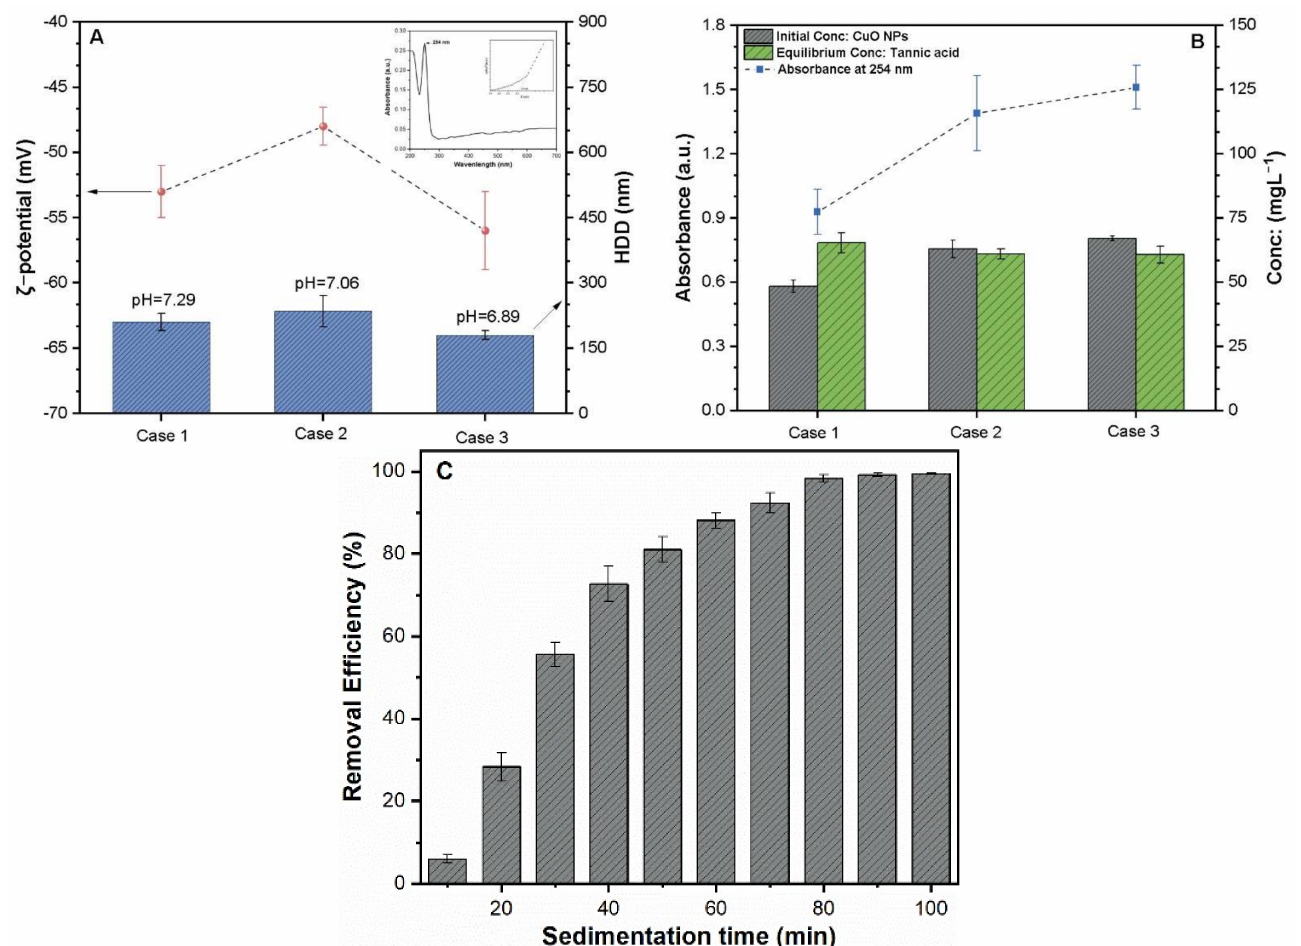
Figure 1. Characteristics of the TA-stabilized CuO NPs suspension. ( A ) ζ − potential and HDD; ( B ) initial and equilibrium concentration of CuO and TA in different groups; ( C ) influence of sedimentation time on the removal efficiency of TA-CuO NP